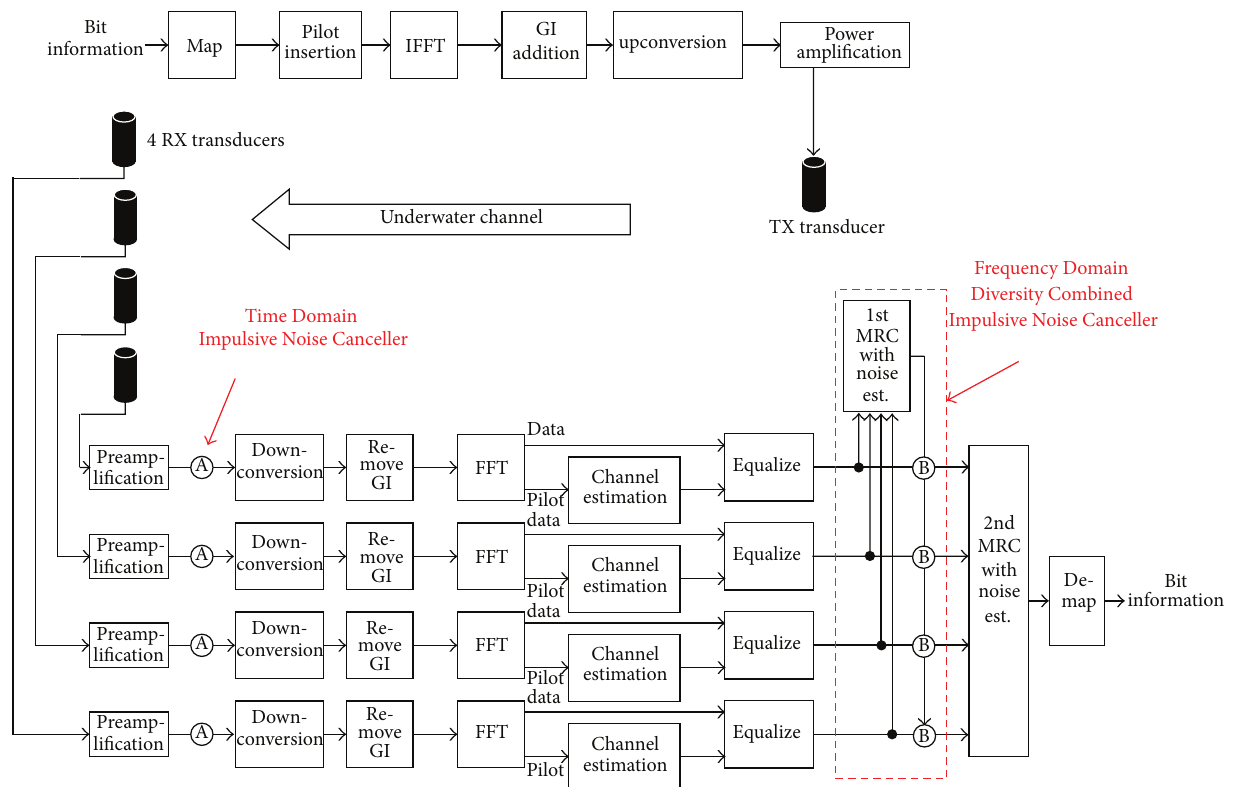
Figure 6: Block diagram of OFDM communication system with Frequency Domain Diversity Combined Impulsive Noise Canceller.